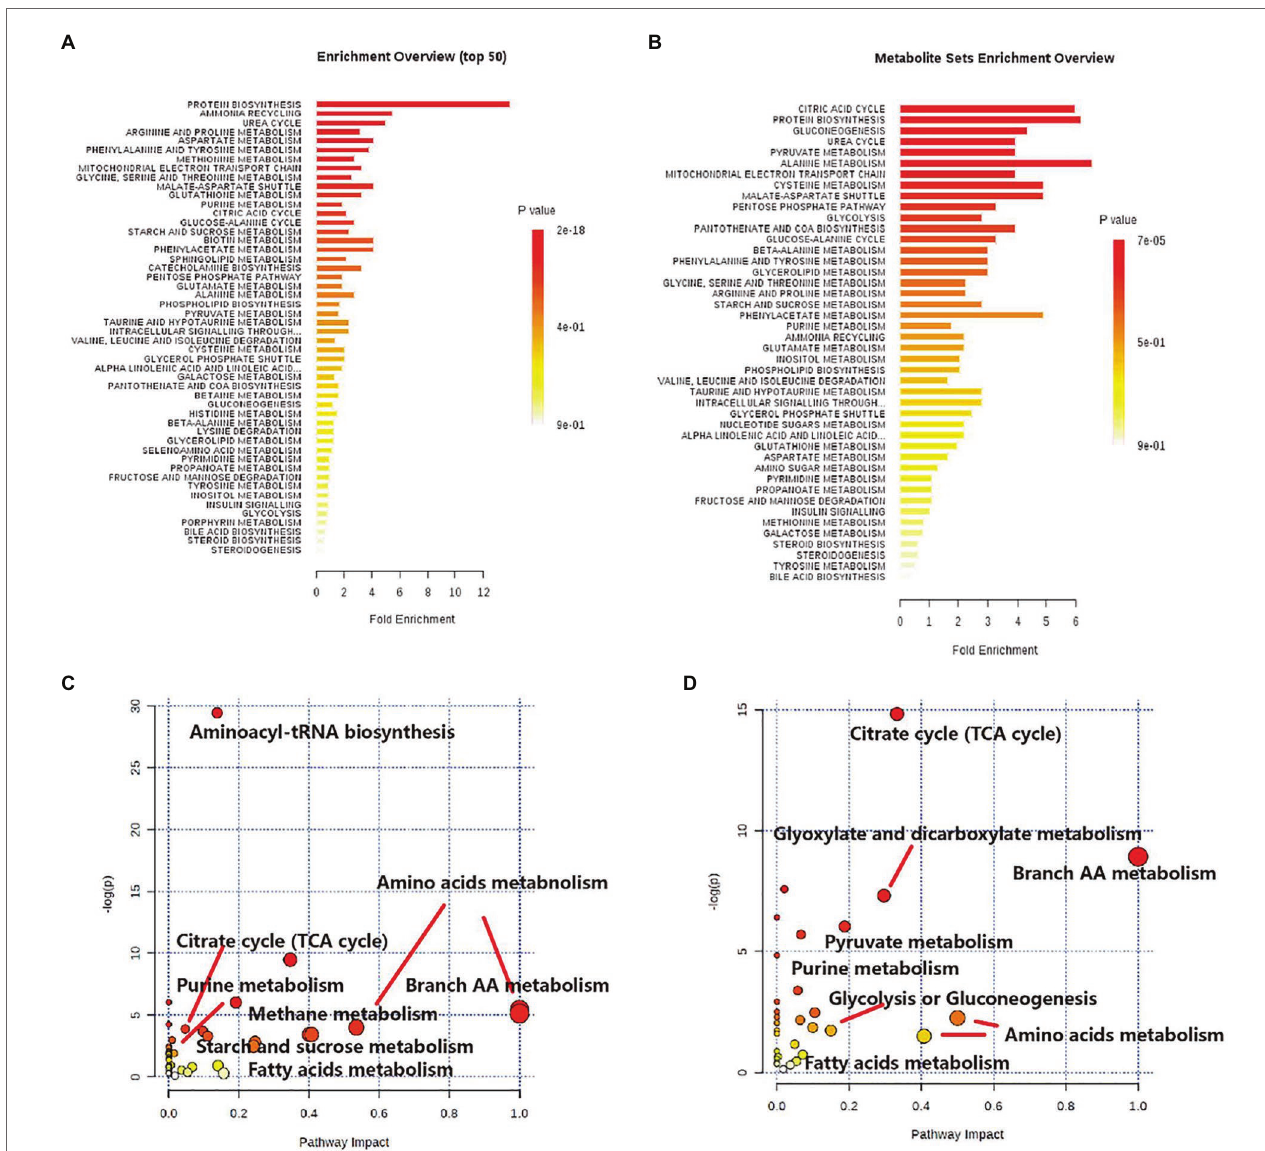
FIGURE 6 | The impact analysis shows the effect of high-altitude hypoxia and LT on primary metabolic pathways based on cardiac tissue metabolome. (A) Enrichment analysis of metabolic sets induced by l -carnitine, relative to model control. (B) Enrichment analysis of metabolic sets modulated by trimetazidine, relative to model control. (C) Impact analysis of metabolic sets modulated by l -carnitine, relative to model control. (D) Impact analysis of metabolic sets modulated by trimetazidine, relative to model